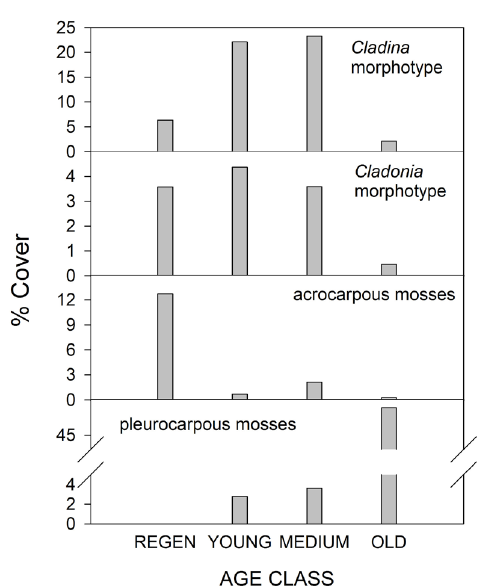
Figure 2. Mean cover (%) by functional group within 50-year age-class intervals (n= 4, 4, 5, and 2 stands re- spectively) for pine-lichen woodlands in central-interior British Columbia. The Cladina morphotype functional group consisted of Cladonia arbuscula , C. rangiferina , and C. stellaris (adapted from Coxson and Marsh,